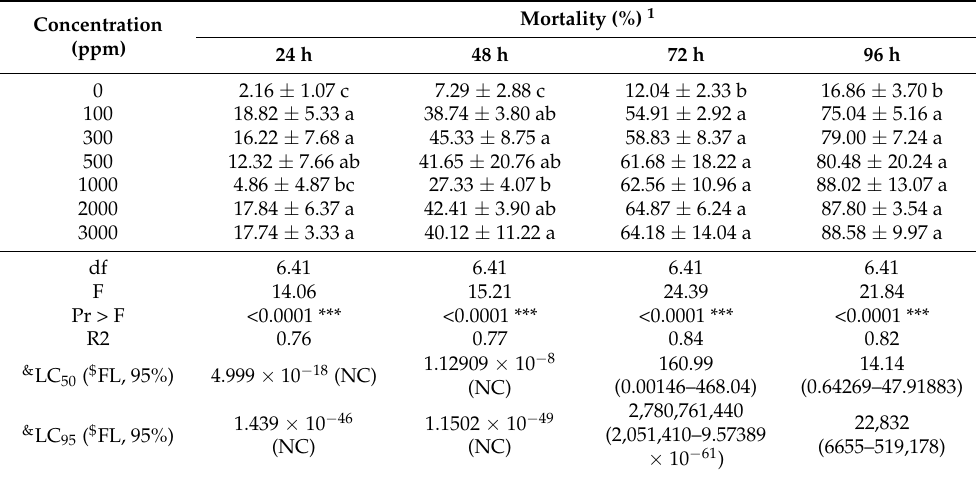
Table 2. Mortality ( ± SD) of tomato psyllid Bactericera cockerelli , at different concentrations of ZnO NPs on tomato leaves in the laboratory.